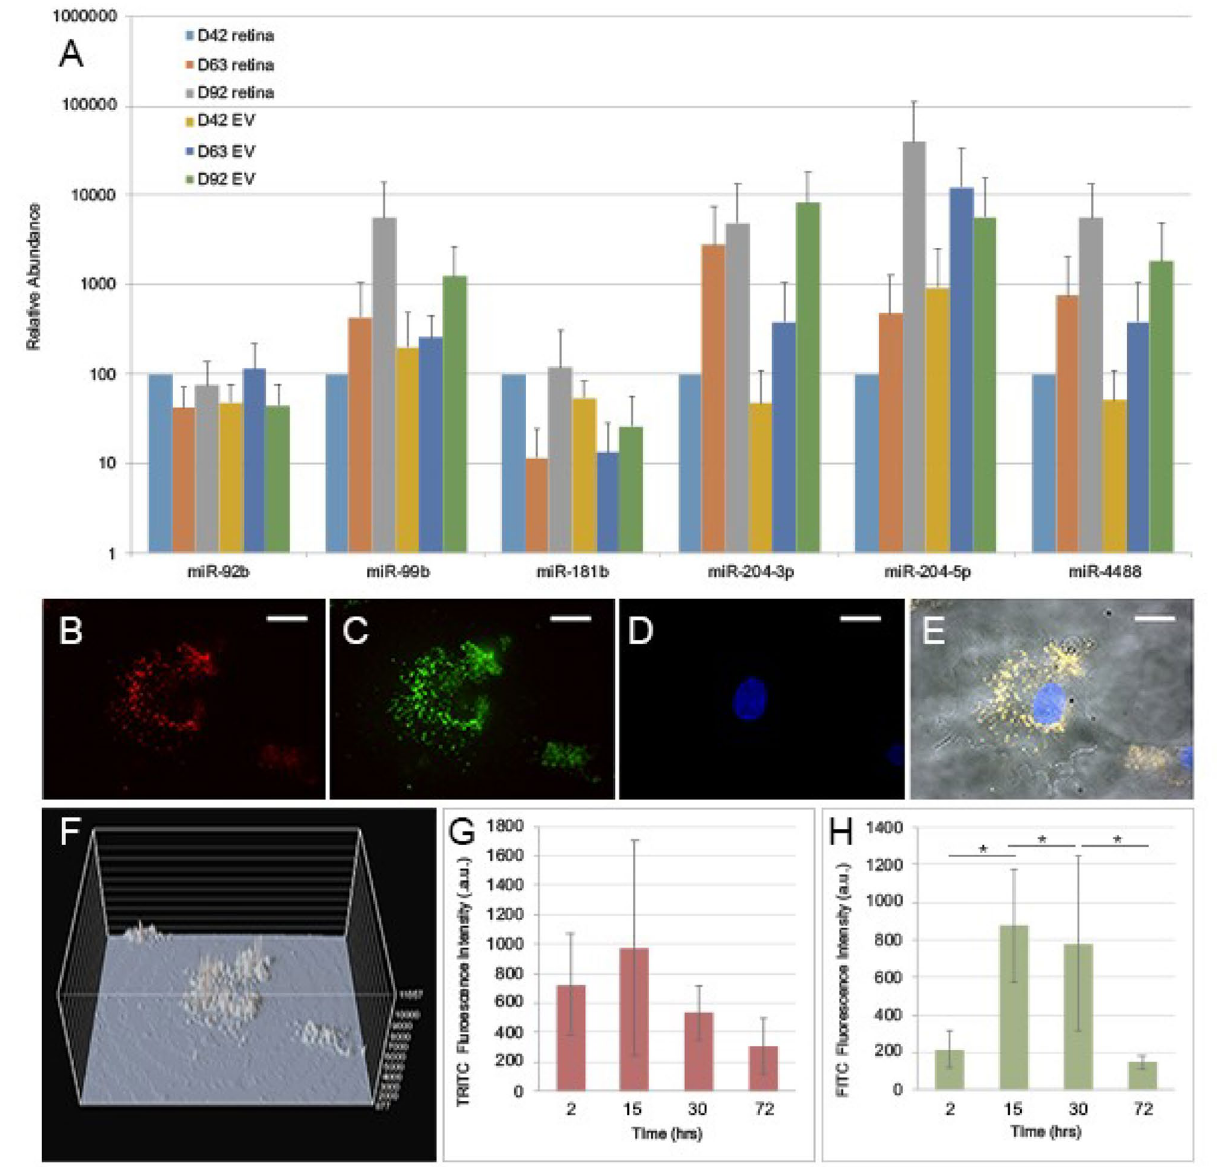
Figure 6. hiPSC-derived 3D retinal organoid and EV miRNA validation and visualization of EV mediated RNA transfer to hRPCs. ( A ) hiPSC-derived 3D retinal organoids and EV cargo were analyzed using qPCR to validate selected miRNA species identified in RNAseq. D42, D63 and D90 retinal organoids and corresponding EVs contained miRNA-92b, miRNA99b, miR181b, miR-204-3p, miR-204-5p and miR-4488. ( B – H ) Fluorescently- labeled EVs from hiPSC-derived 3D retinal organoids were incubated with and taken up by multipotent human retinal progenitor cells (hRPCs). EVs with co-fluorescently labeled lipid membranes (PKH26-TRITC; ( B ) and RNA (SYTO RNASelect-FITC; C ) are taken up by hRPCs (DAPI labeling of hRPCs nuclei; D ); ( E ) overlay of A-D with hRPC morphology in phase; scale 10um. Overlay revealed internalized EVs with visible co-localization of labeled RNA and lipid membrane throughout the cytoplasm and in the proximity of the perinuclear region at 30 h of incubation. F ) 3D projection map of the cells depicted in C showing EV-labelled RNA intensity throughout hRPCs cytoplasm. ( G – H ) Dynamics of EV uptake, retention, and reduction by hRPCs. hRPCs were incubated with labeled EVs for 15rs, at which point cells were rinsed and new media, free of labelled EVs, added. ( G ) PKH26 lipid signal showed an increasing trend up to 15 h followed by a decreasing trend after removal of labeled EVs. ( H ) Labeled EV RNA internalized by hRPCs showed significant increases from 2 to 15 h: t-value: 2.42, P < .05; 2 to 30 h: t-value: − 2.42, P < .05, and a significant decrease from 15 to 72 h: t-value is 2.38, P <